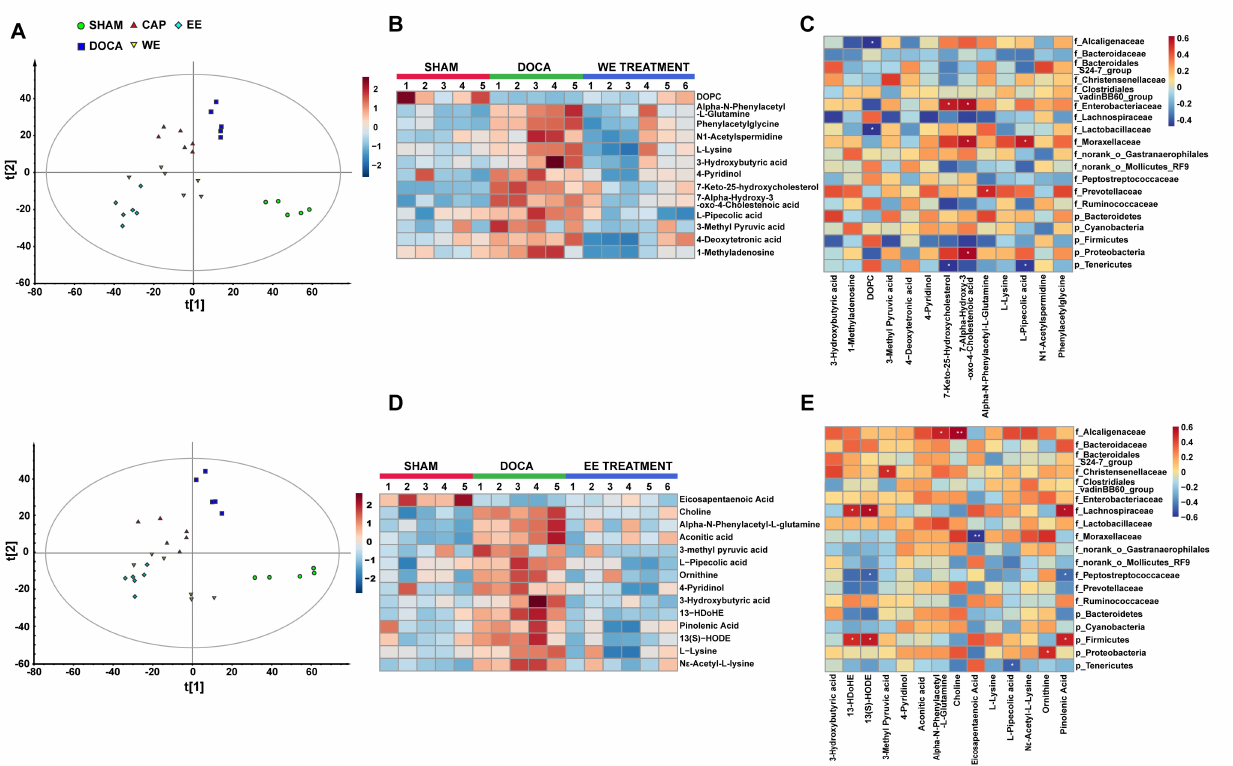
Figure 8. L. rhamnosus AC1-fermented soymilk extract alters potential gut microbiota-associated metabolites levels in DOCA-salt-induced hypertension. ( A ) Partial least squares-discrimination analysis (PLS-DA) score plots for discriminating the serum metabolome from Sham, DOCA, CAP, WE- treated and EE-treated groups (Upper: negative mode; Lower: positive mode). ( B ) Heatmap of the differential metabolites that were altered by DOCA and then regulated by WE. ( C ) Heatmap analysis of the spearman correlation of differential metabolites and gut microbiota after WE administration. Red represents positive correlation, and blue indicates negative correlation. ( D ) Heatmap of the differential metabolites that were altered by DOCA and then regulated by EE. ( E ) Heatmap analysis of the spearman correlation of differential metabolites and gut microbiota after EE administration. Red represents positive correlation, and blue indicates negative correlation. n = 4–6. * p < 0.05, ** p <